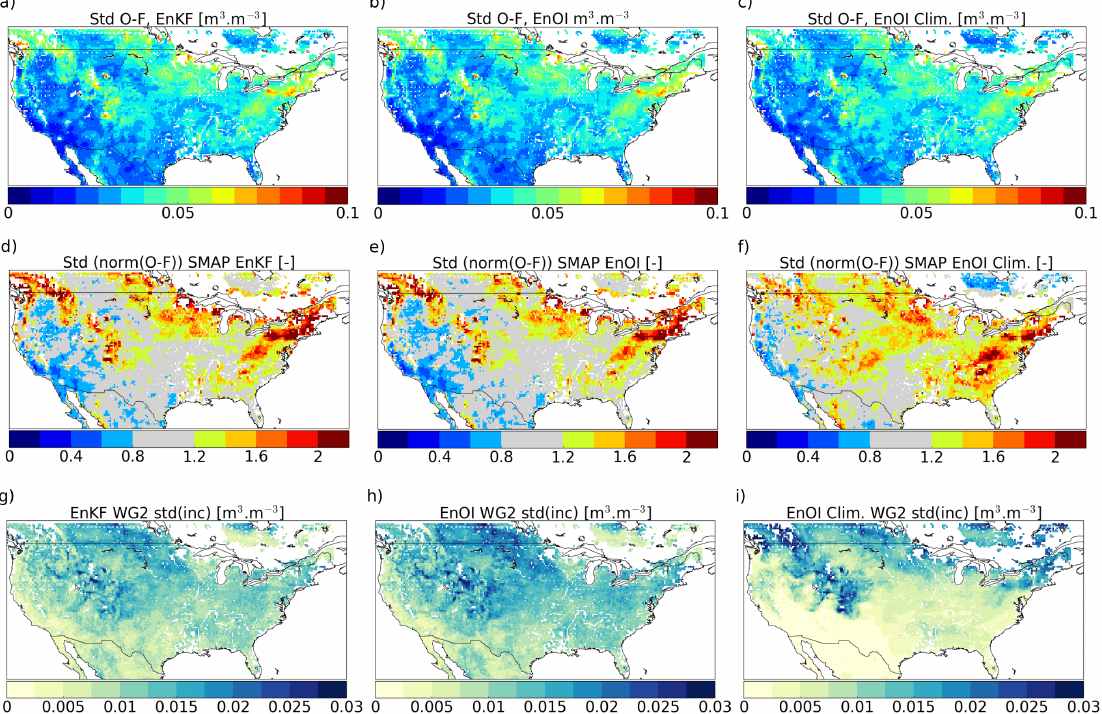
Figure 4. Assimilation diagnostics for the period from 31 March 2015 to 31 December 2016, for the EnKF, EnOI and EnOI-Clim. ( a – c ) standard deviation of the Observation-minus-Forecast (O-F) soil moisture residual (m 3 m − 3 ), blue/red colours indicate low/high O-F residuals; ( d – f ) standard deviation of normalized innovations (dimensionless), blue/red colours indicate too large/small assumed errors; ( g – i ) standard deviation of the observation layer soil moisture increments (m 3 m − 3 ), yellow/blue colours indicate low/high typical